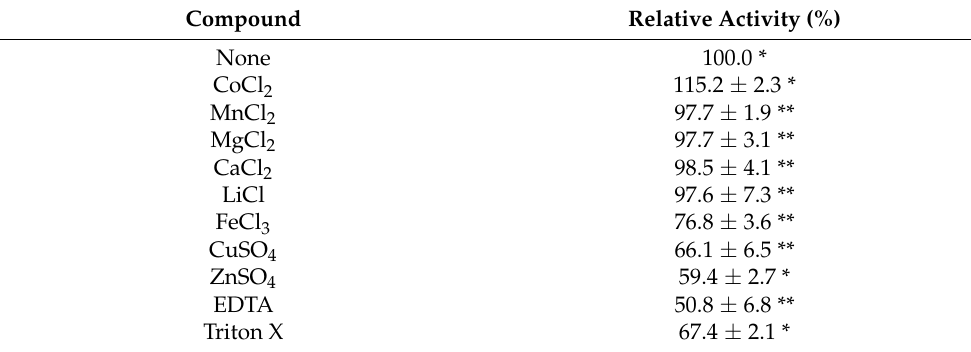
Table 2. Effects of metal ions (1 mM) and chemical reagents (5 mM) on the activity of